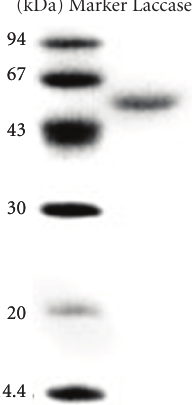
Figure 3: Sodium dodecyl sulfate-polyacrylamide gel electrophore- sis results. Left lane: molecular mass markers from Ge Health- care. From top downward: phosphorylase b (94kDa), bovine serum albumin (67kDa), ovalbumin (43kDa), carbonic anhydrase (30kDa), soybean trypsin inhibitor (20kDa), and α -lactalbumin (14.4kDa). Right lane: purified laccase (fraction SU1).